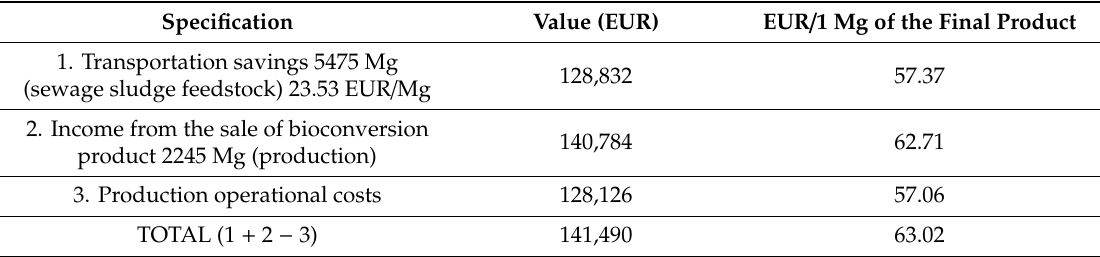
Table 5. Profitability of sewage sludge based production of energy